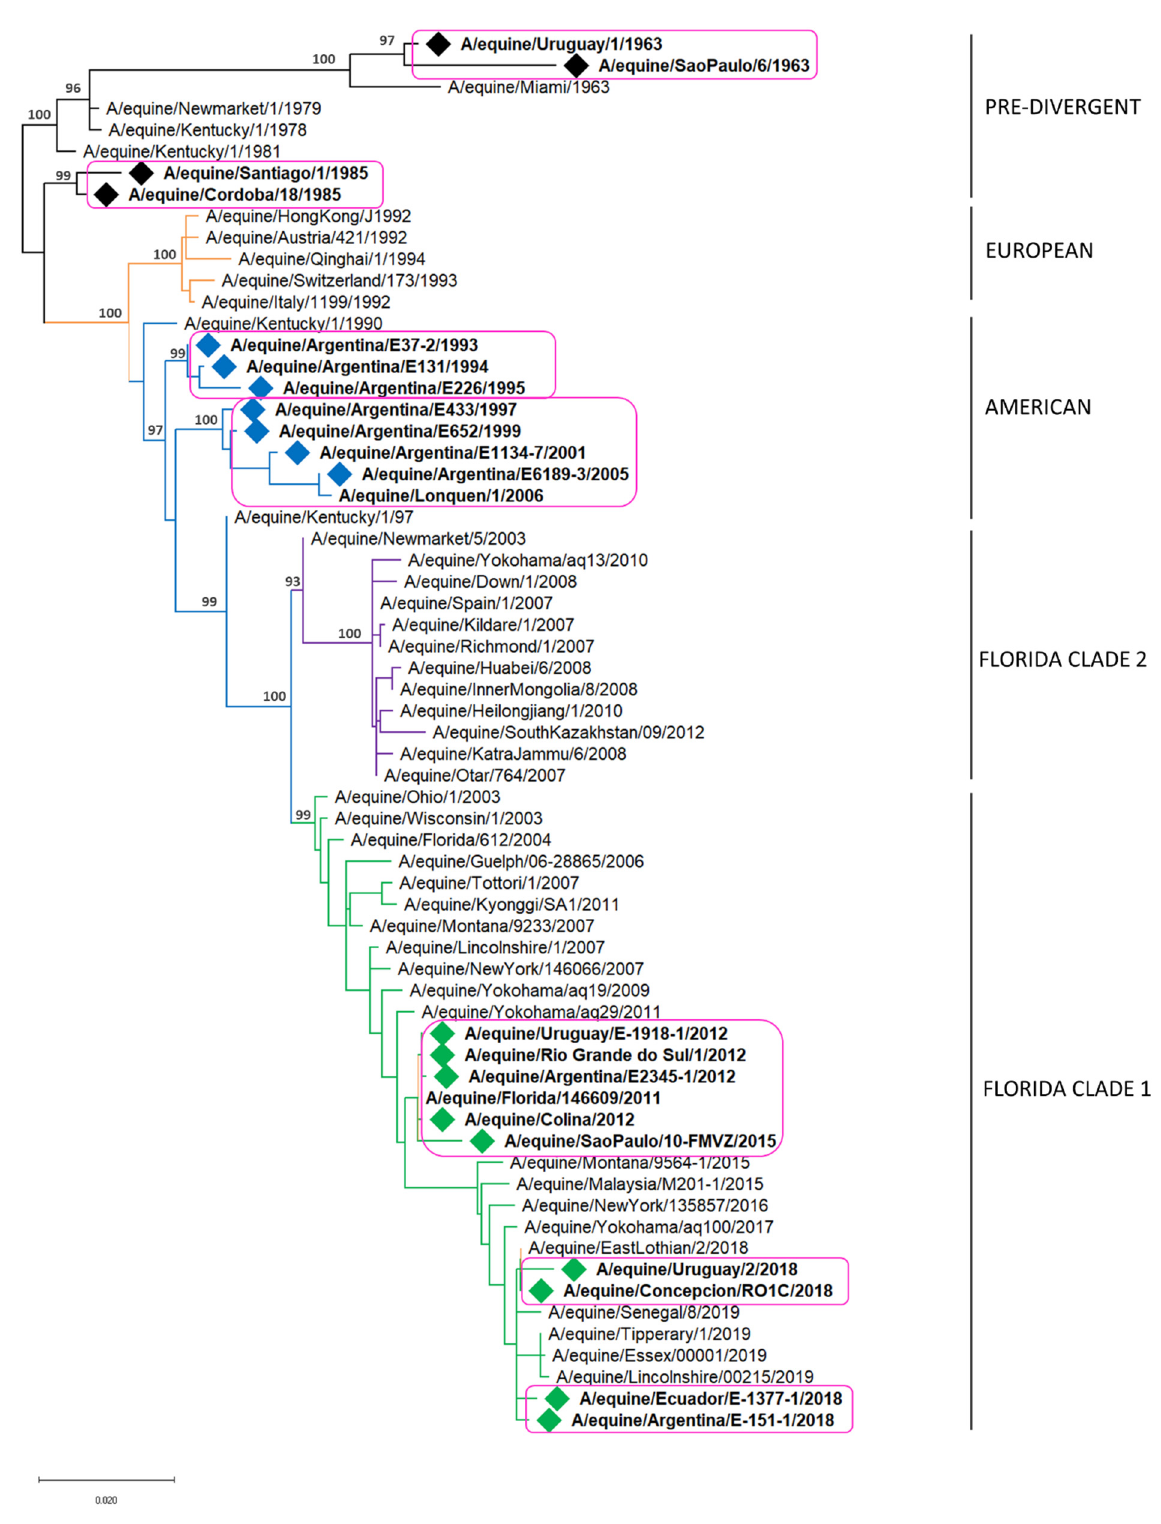
Figure 2. Maximum likelihood phylogenetic tree of the HA gene of H3N8 EIV. Bootstrap values obtained after 1000 replicates are shown at major nodes. Magenta boxes enclose South American strains. Colored diamonds ( ♦ ) represents the strains detected in South America: pre-divergent lineage (black), American lineage (blue), Florida clade 1 (green). The strains circulating in Brazil in 2015 grouped together within the Florida clade 1 and showed similarities with the ones detected in other South American countries in